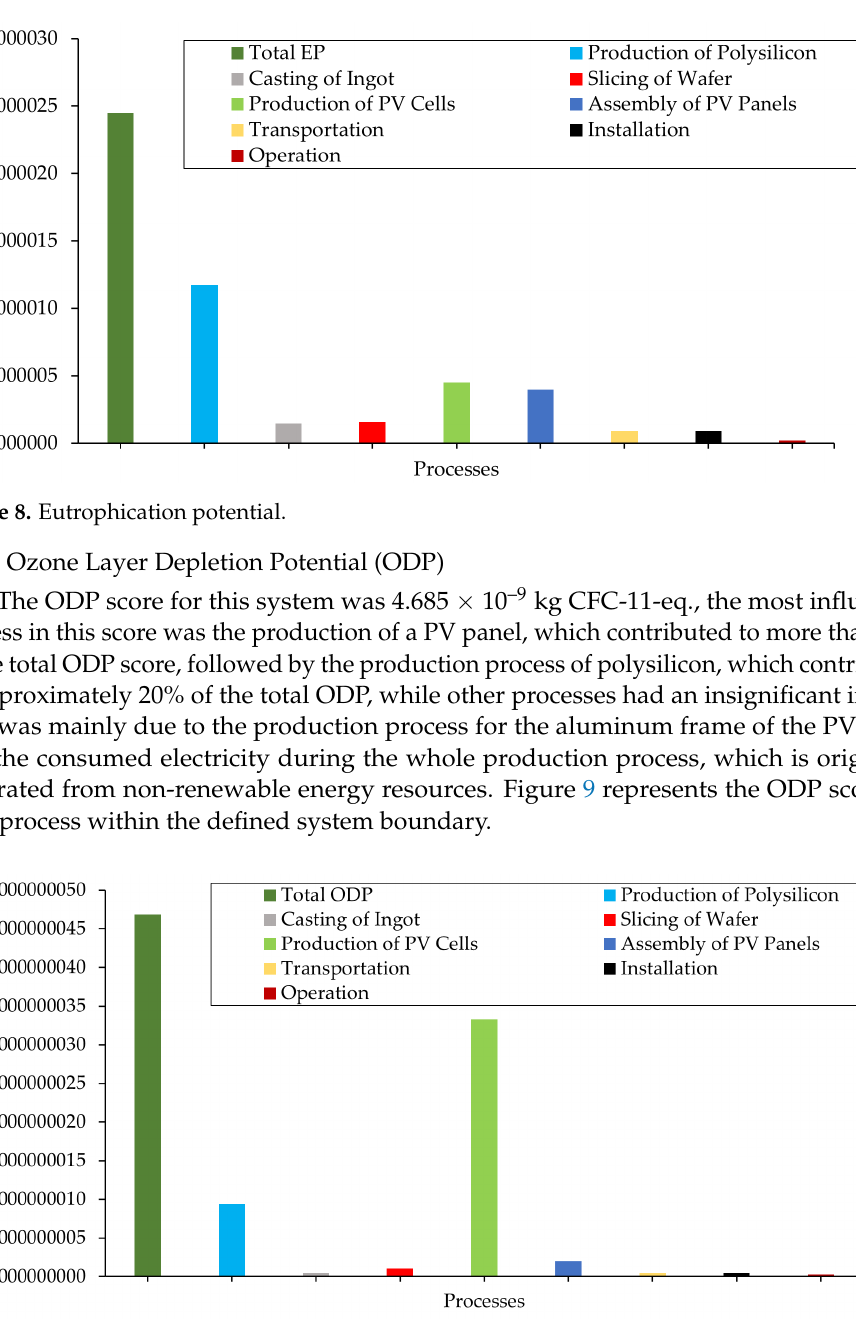
Figure 10. Photochemical ozone creation potential . 4.1.7. Human Toxicity Potential (HTP) The HTP score for this system was 2.38 × 10 –2 kg 1,4-DB-eq., where the production of polysilicon was responsible for more than 30% of this score, followed by the slicing pro- cess of the wafer with approximately 25%, and the production of PV panels with approx- imately 20%, while each one of the remaining processes had an insignificant contribution, as illustrated in Figure 11.